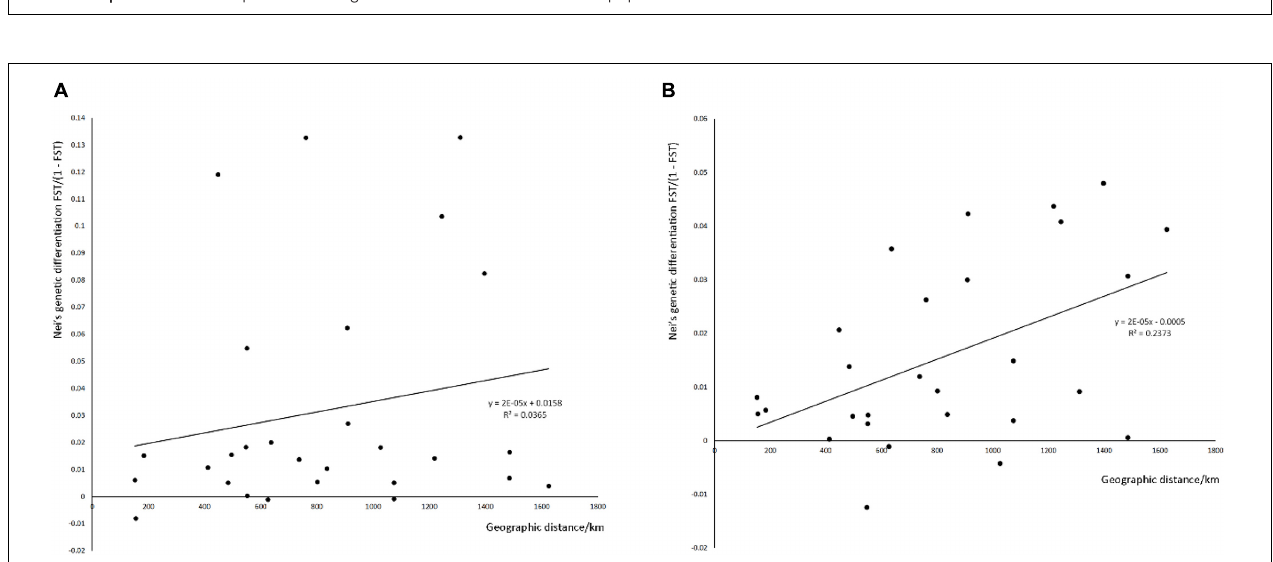
FIGURE 3 | Mantel test of the geographic distance and Nei’s genetic distance based on haplotypes of cox1 gene (A) and microsatellites (B) .